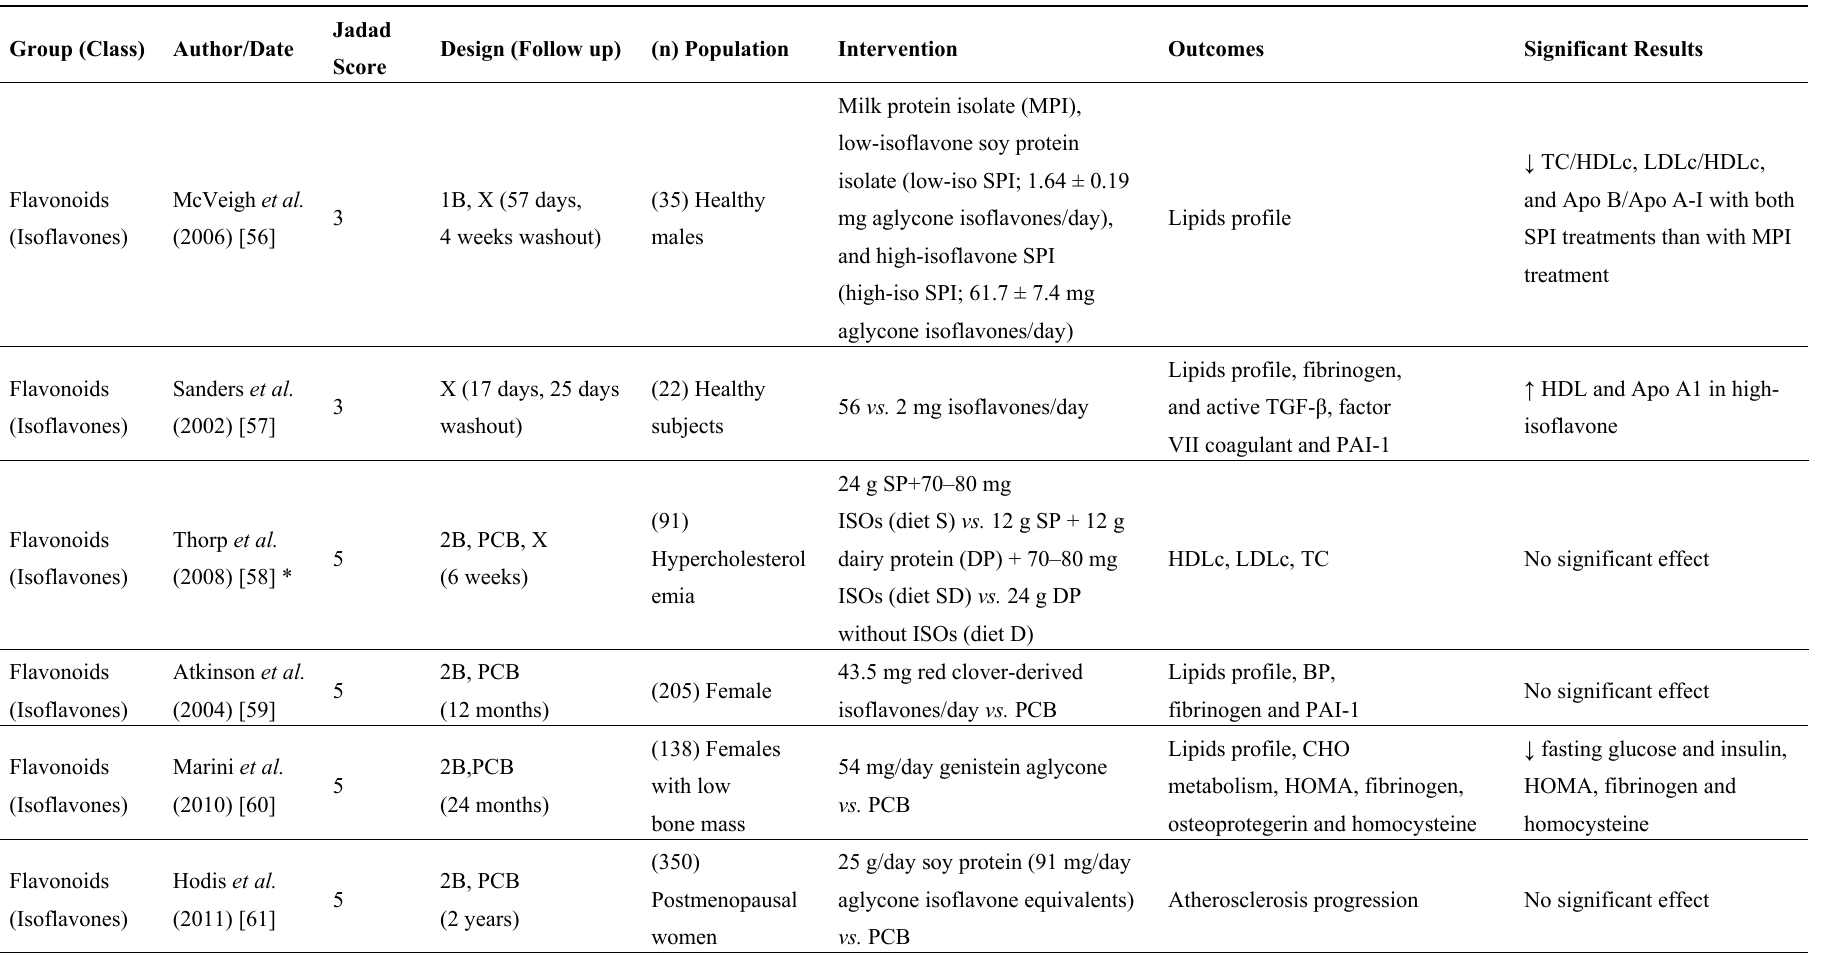
Table 3. RCTs of polyphenols (isoflavones and procyanidins) in CVD